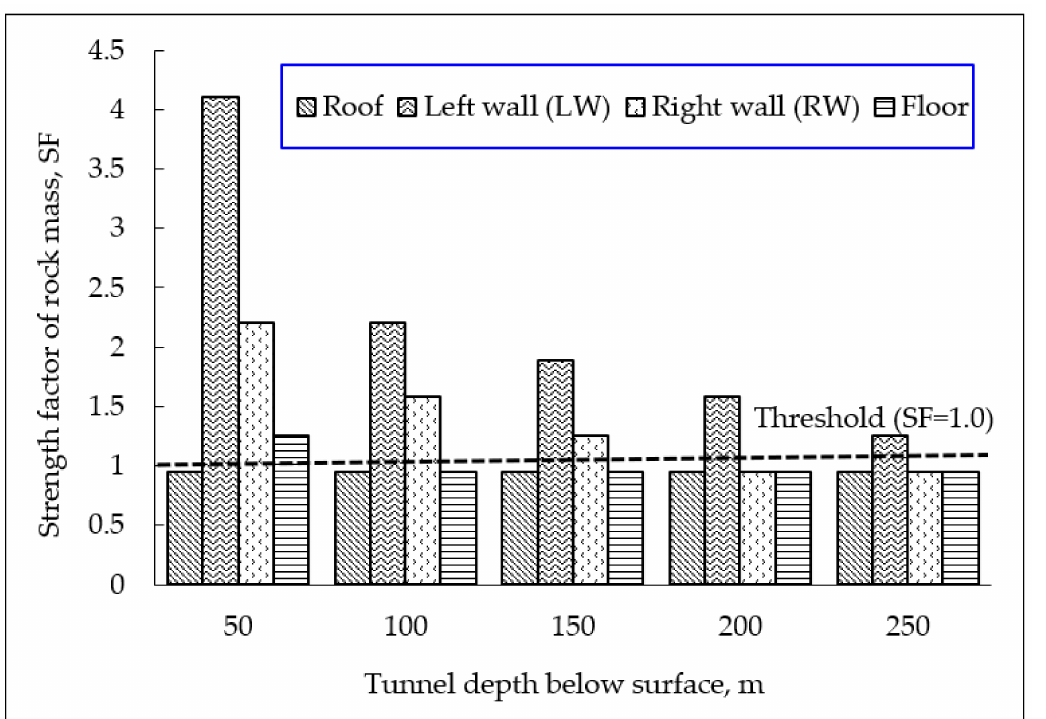
Figure 19. Strength factor of rock mass around tunnel opening at various depths below